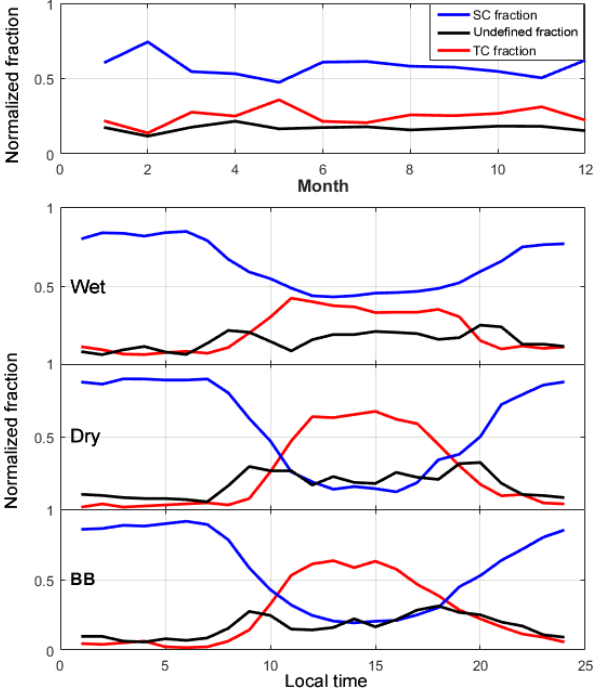
Figure 3. Monthly and diurnal variations in TCs (red), SCs (blue), and undefined (black) fractions for each